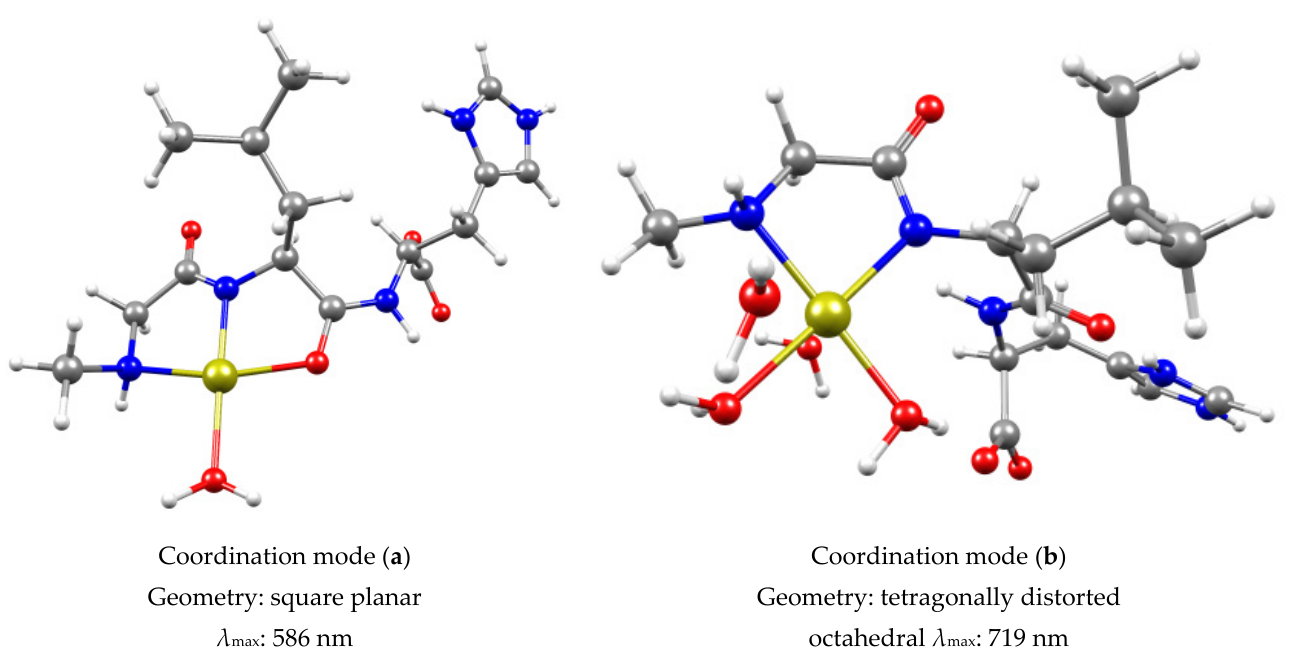
Figure 13. Visual representation of the proposed structures for the ML species of ( a ) Cu-GLH, ( b ) Cu-Sar-LH, as well as their geometries and calculated λ max obtained at B3LYP/6-31++G ** in water.